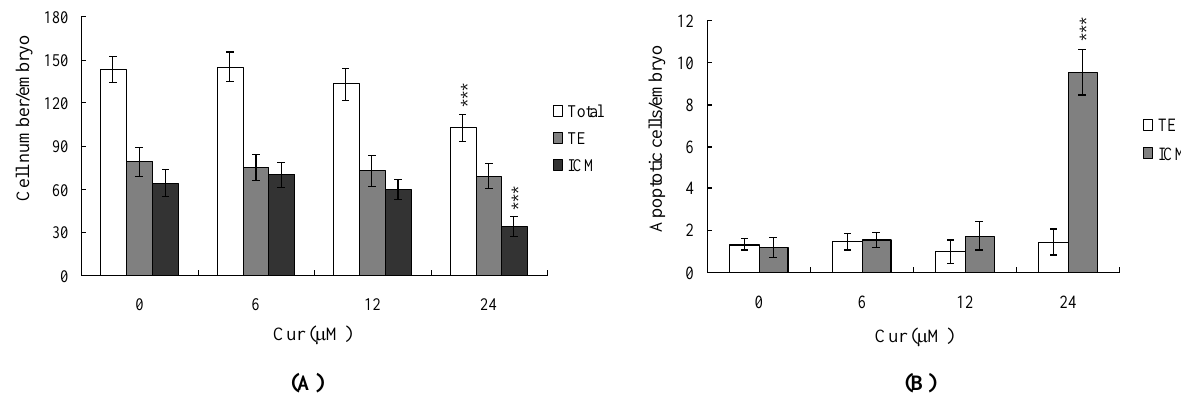
curcumin (Cur; 6, 12 or 24 μM) for 24 h or left untreated. (A) The total number of cells per blastocyst and cell numbers in the inner cell mass (ICM) and trophectoderm (TE) were counted. (B) The percentages of Annexin V-positive/PI-negative cells in the blastocysts of each group were examined. Data are based on at least 250 blastocyst samples from